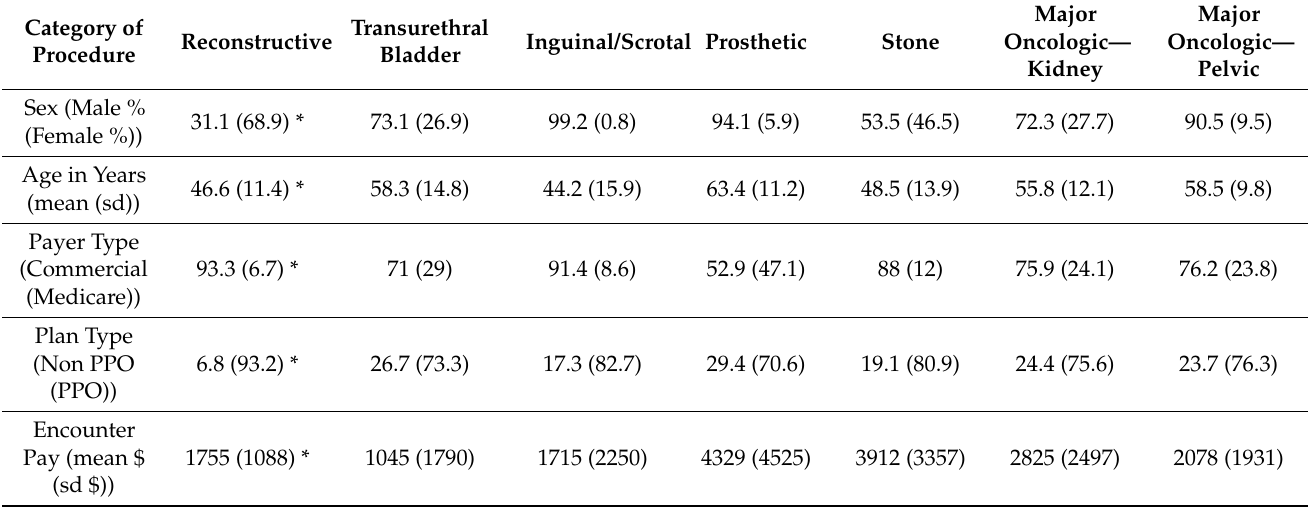
Table 4. Demographic information among patients who undergo reconstructive urologic procedures compared to other urologic